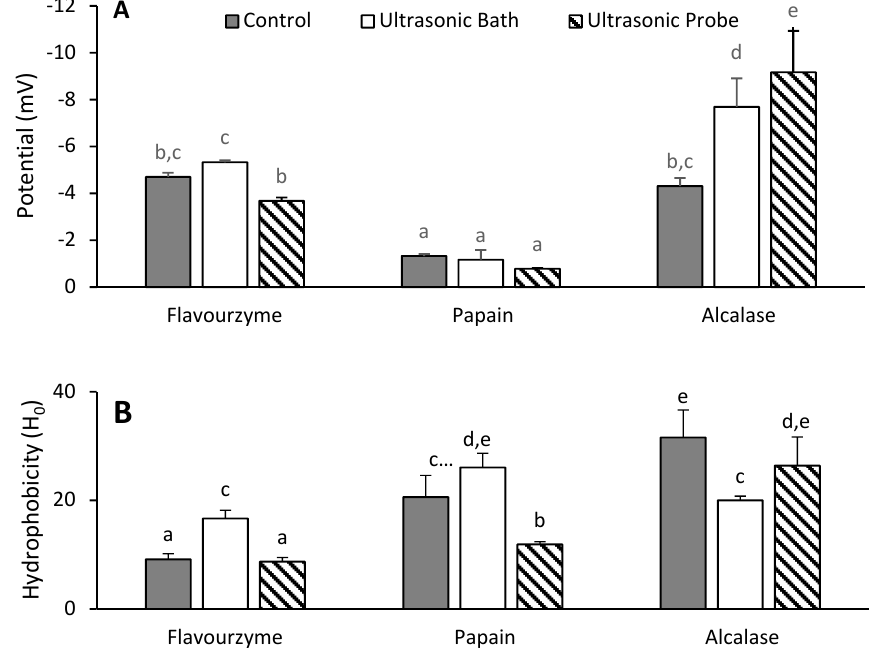
Figure 1. ( A ) Zeta potential (mV) of hydrolysates and ( B ) hydrophobicity index (H 0 ) for protein hydrolysates, expressed as the initial slope of the relative fluorescence versus the concentration of protein. The letters above each bar represent significant di ff erences as determined with a least significant di ff erence (LSD) test in a one-way ANOVA ( p -value < 0.05).